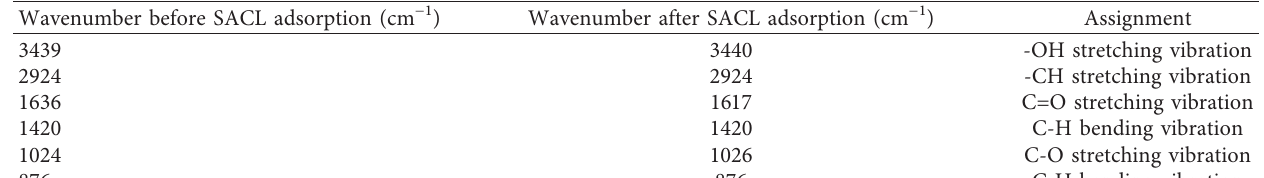
Figure 2: FTIR spectra of SACL before and after adsorption of wastewater Cu (II) and Cd (II). Table 1: Position of the main peaks in FTIR spectra of PEO, SA, and SACL.